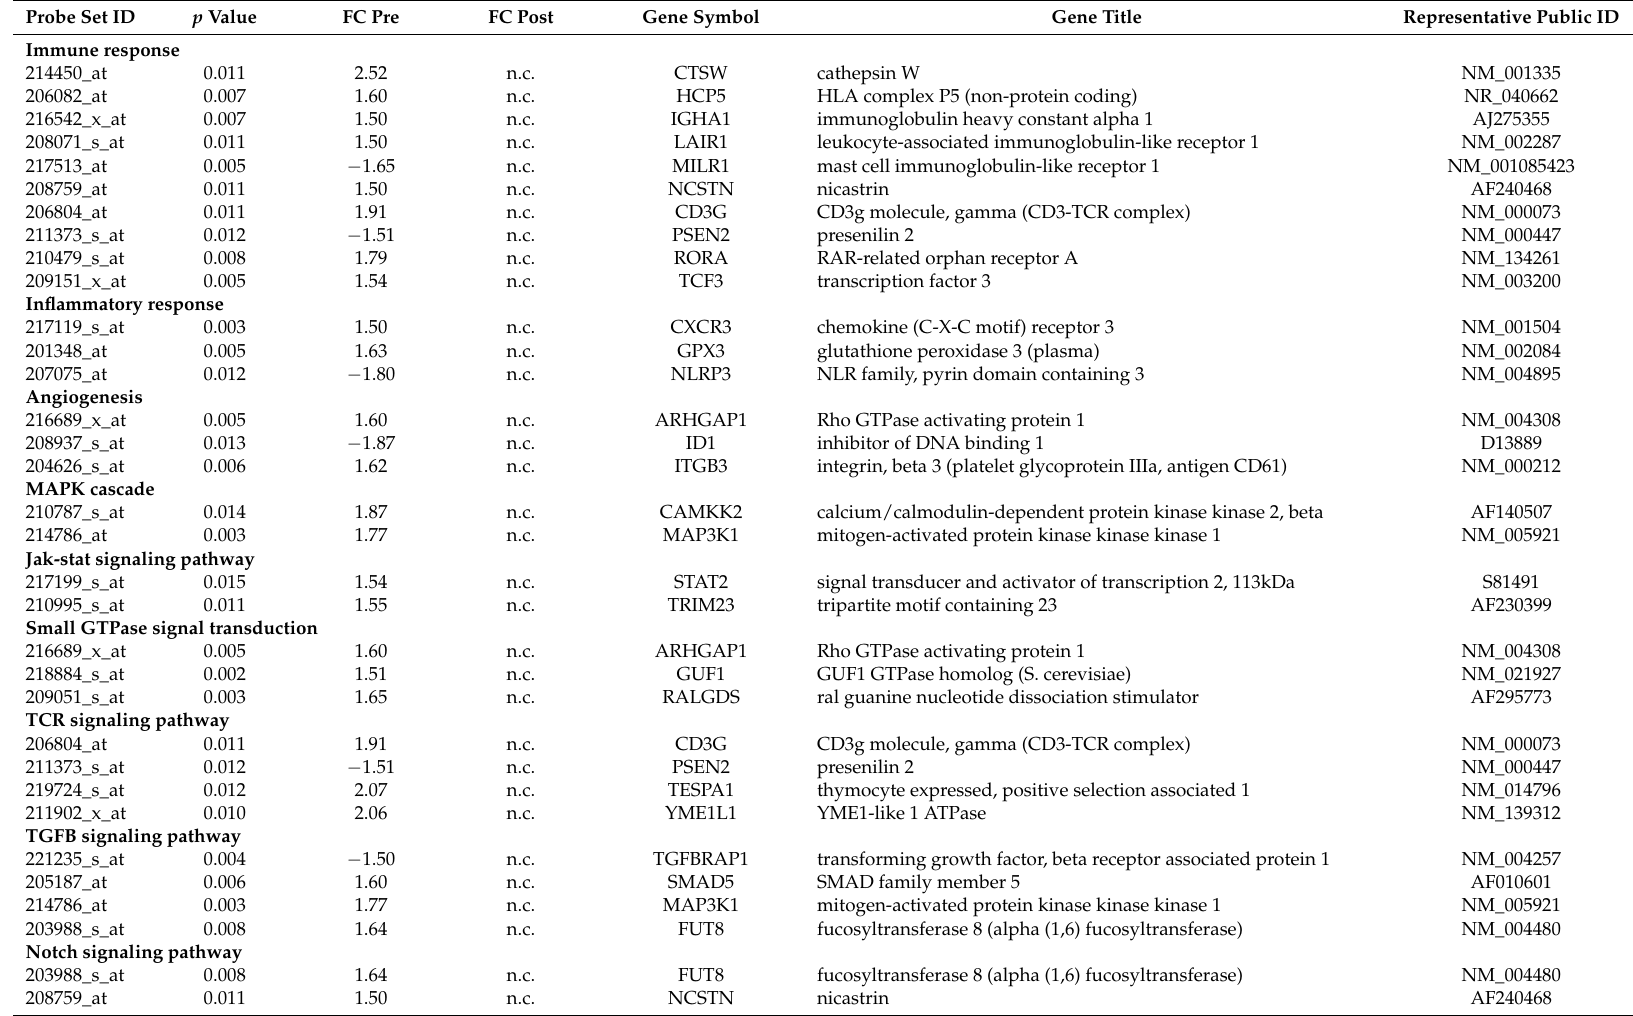
Table 6. Genes modulated only before treatment in AS patients-group 2. n.c.: not